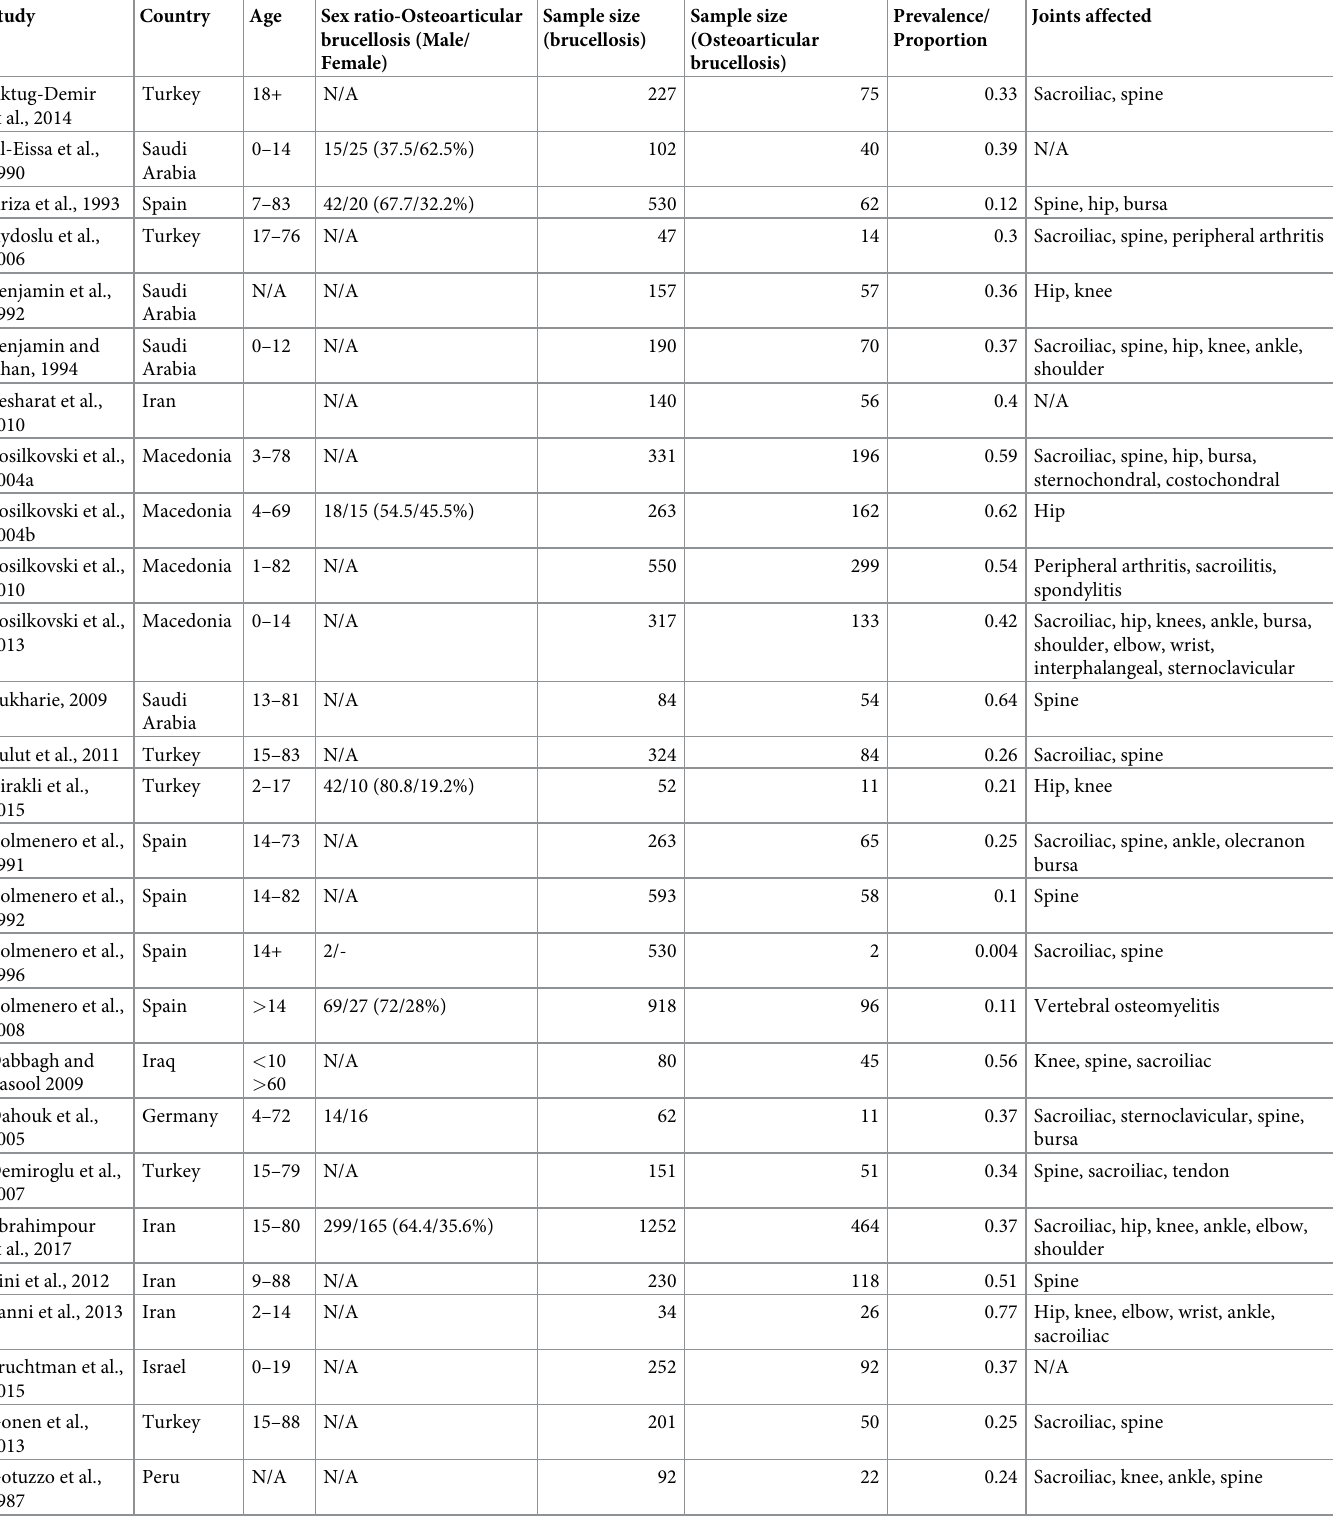
Table 1. Characteristics of included